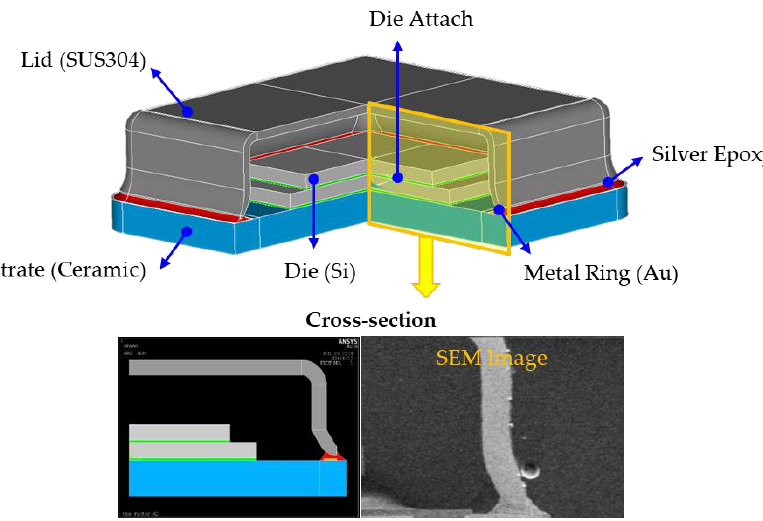
Figure 8. The finite element model of the hermetic MEMS package with metal lid. Table 1. The material properties of the finite element model.